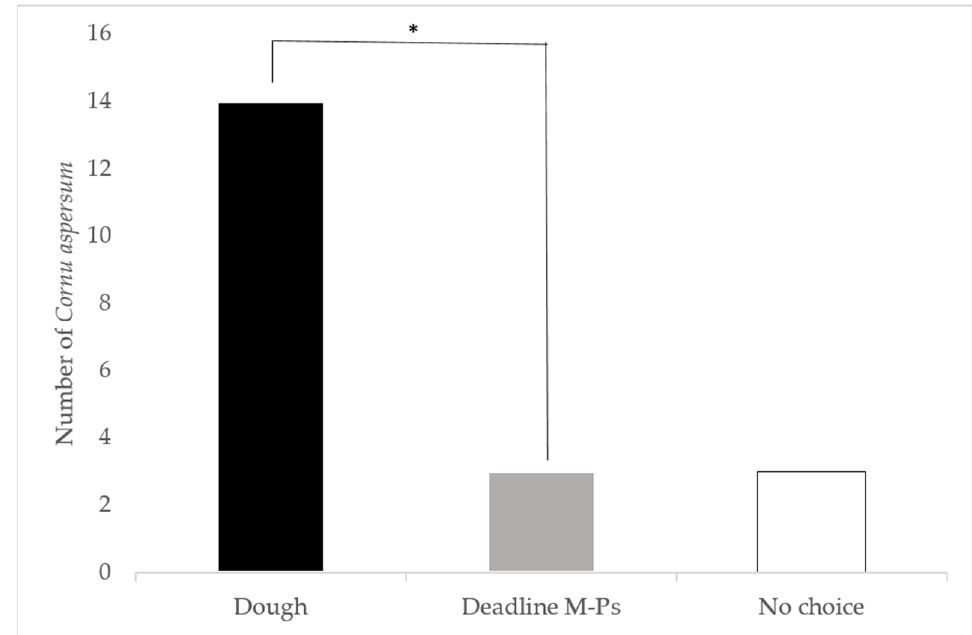
Figure 2. Direct comparison of the attraction of Cornu aspersum to two day old bread dough and Deadline ® M-Ps™ in laboratory choice trials. *: Snails significantly preferred the dough over the metaldehyde bait (X 2 = 5.88, p < 0.05).